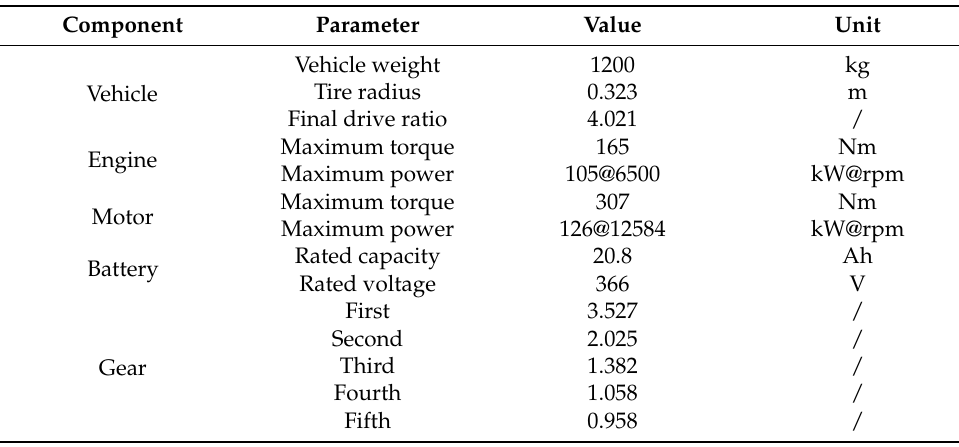
Figure 2. The schematic of the PHEV configuration. Table 1. Vehicle and component parameters in the studied